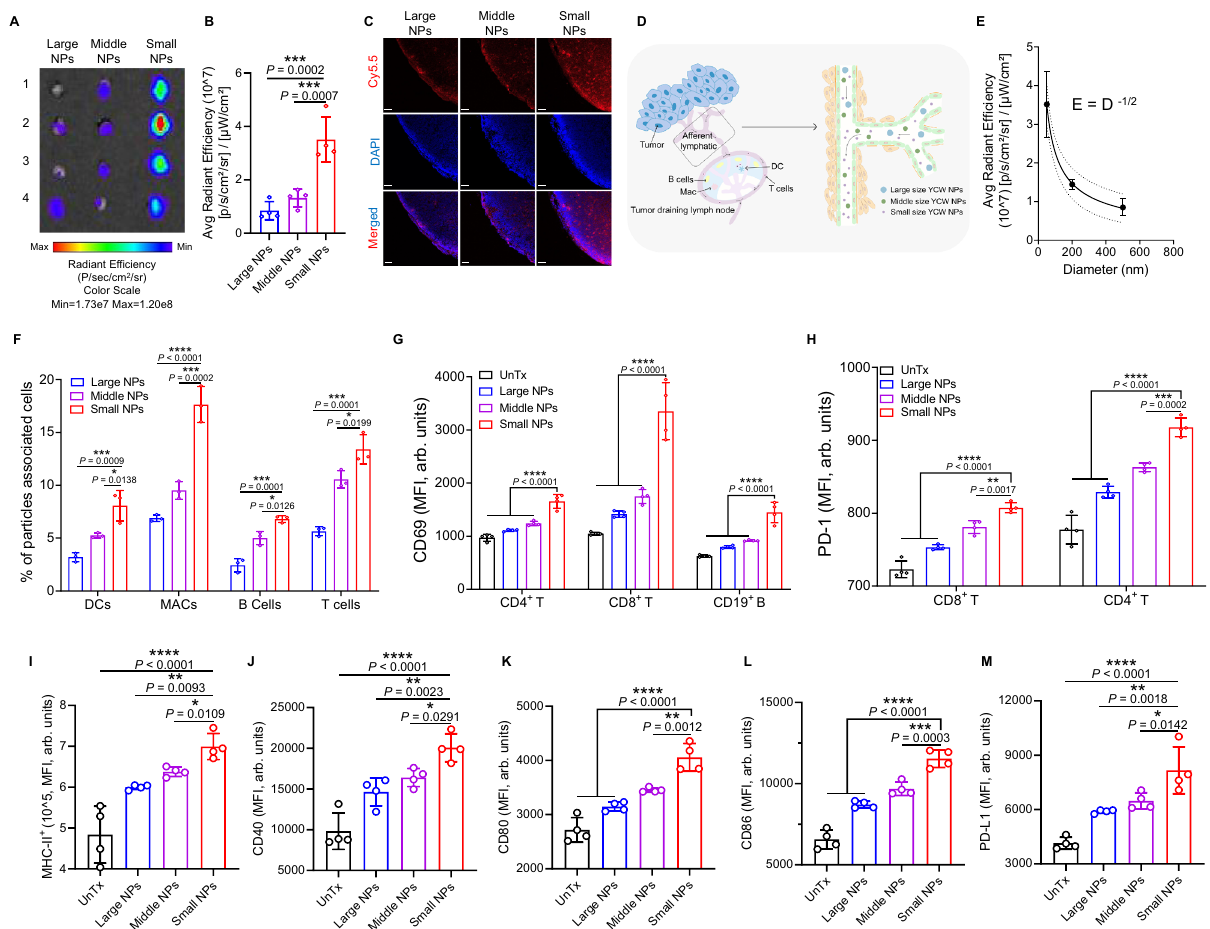
Fig. 4 Accumulation of YCW NPs to tumor draining lymph nodes (TDLNs) and activation of immune cells in vivo. A Fluorescence imaging of TDLNs ex vivo after injection of three different YCW NPs for 48 h. B Signal quanti fi cation of Cy5.5-labelled YCW NPs in TDLNs ( n = 4). C Representative confocal imaging of TDLNs to monitor the signal of Cy5.5 (blue: DAPI; red: Cy5.5; Scale bar = 50 µ m, n = 3). D Imaging of draining lymph nodes and model of the distribution of YCW NPs in lymph nodes vessels. E Mathematical model to explain the relationship between size and distribution behavior ( n = 3). F Proportions of particles associated cells of tumor draining lymph nodes after intratumorally injection for 48 h ( n = 3). G Corresponding quanti fi cation of MFI of CD69 expression on CD4 + T cells, CD8 + T cells, CD19 + B cells ( n = 4) after injection of YCW NPs for 48 h. H Corresponding quanti fi cation of MFI of PD-1 expression on CD4 + T cells and CD8 + T cells ( n = 4) after injection of YCW NPs for 48 h. I – M Corresponding quanti fi cation of MFI of MHC-II ( I ); CD40 ( J ); CD80 ( K ); CD86 ( L ); PD-L1 ( M ) expression on DCs ( n = 4) after injection of YCW NPs for 48 h. Statistical signi fi cance between different groups was obtained by one-way ANOVA using the Tukey post-test. **** P < 0.0001; *** P < 0.005; ** P < 0.01; * P < 0.05. Data are means ± SD. DC: dendritic cells, MFI: mean fl uorescence intensity, arb. units: arbitrary